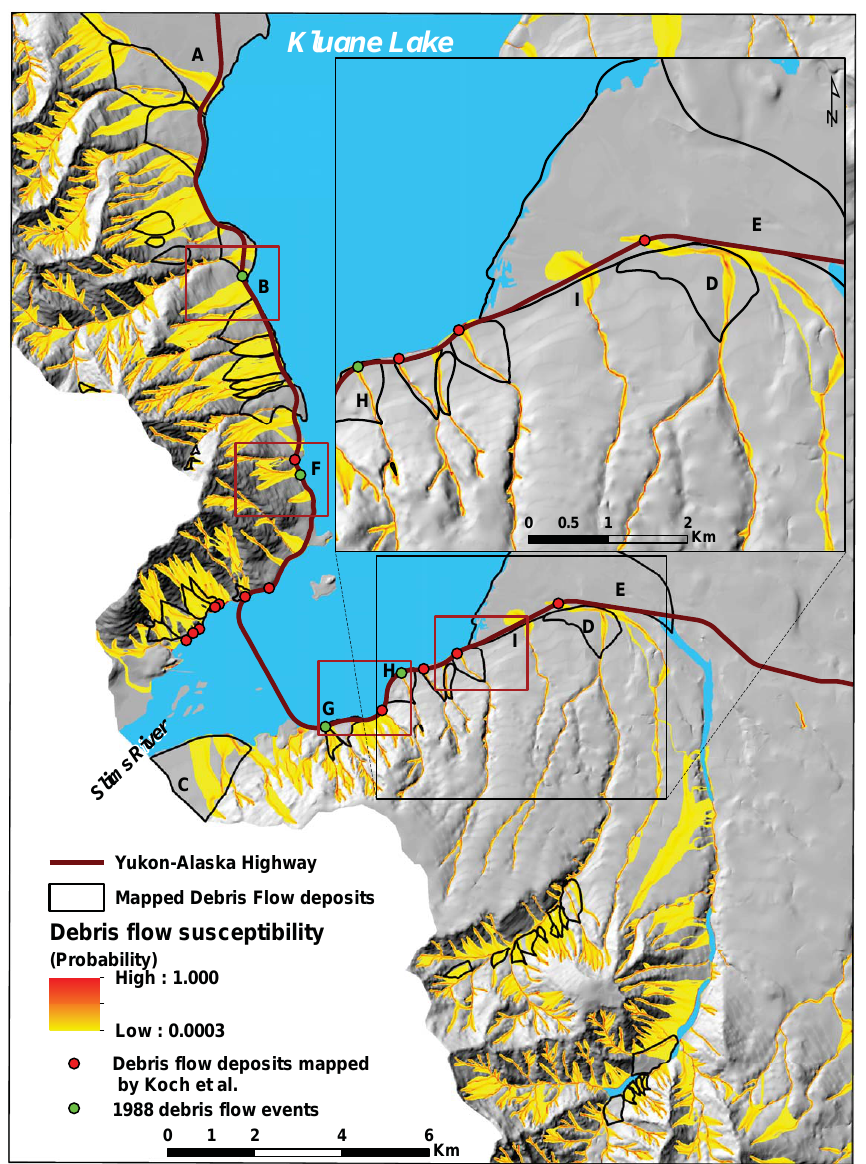
Figure 7. Debris flow susceptibility map derived from propagation of source areas using ω = 600 and µ = 0.02. Minor propagation is seen reaching the southwest edge of debris flow deposit E. Also note the propagation pattern in C, D, and I. Debris flow susceptibility displays a good correlation with the mapped debris flow deposits (black lines from Blais-Stevens, 2010a), the documented 1988 event from Evans and Clague (1989; green dots), and from the detailed study from Koch et al. (2014; red dots).